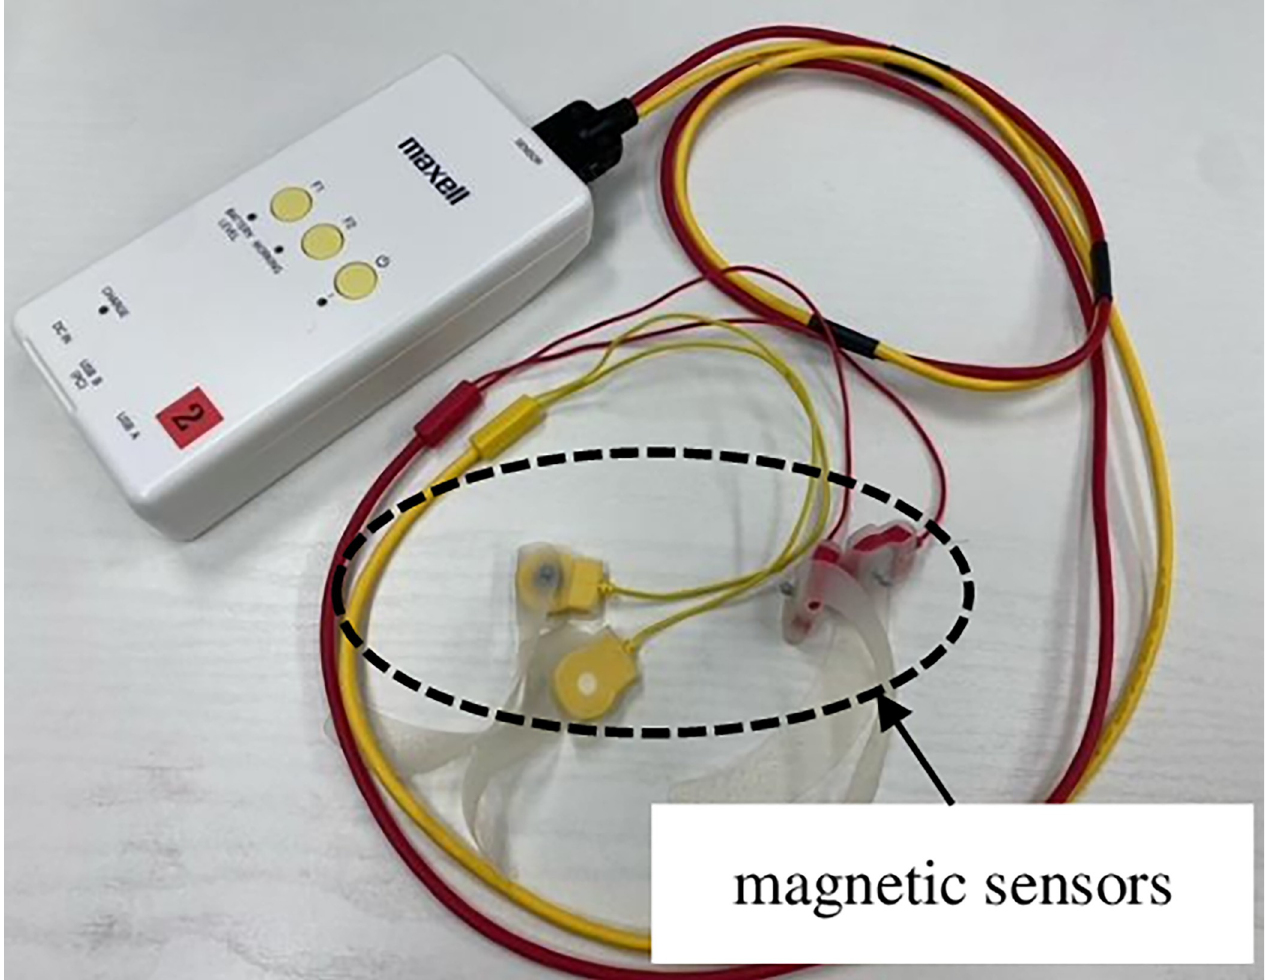
Fig 1. The UB-2 finger-tapping device with magnetic sensors. Yellow cables were used for the left-hand side, and red cables were used for the right-hand side. The magnetic sensor was attached to the dorsal surface of the thumb and index finger and fixed with a rubber